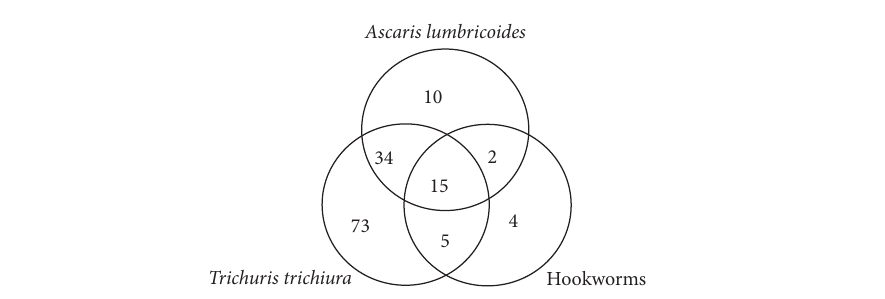
Figure 2: Diagram presenting the number of single and coinfections with distinct soil-transmitted Table 1: Factors associated with ascariasis in children living in the urban area of Bagre, Par´a State, Brazilian Amazon. Positive for A. lumbricoides , N (%) Crude OR (95% CI)